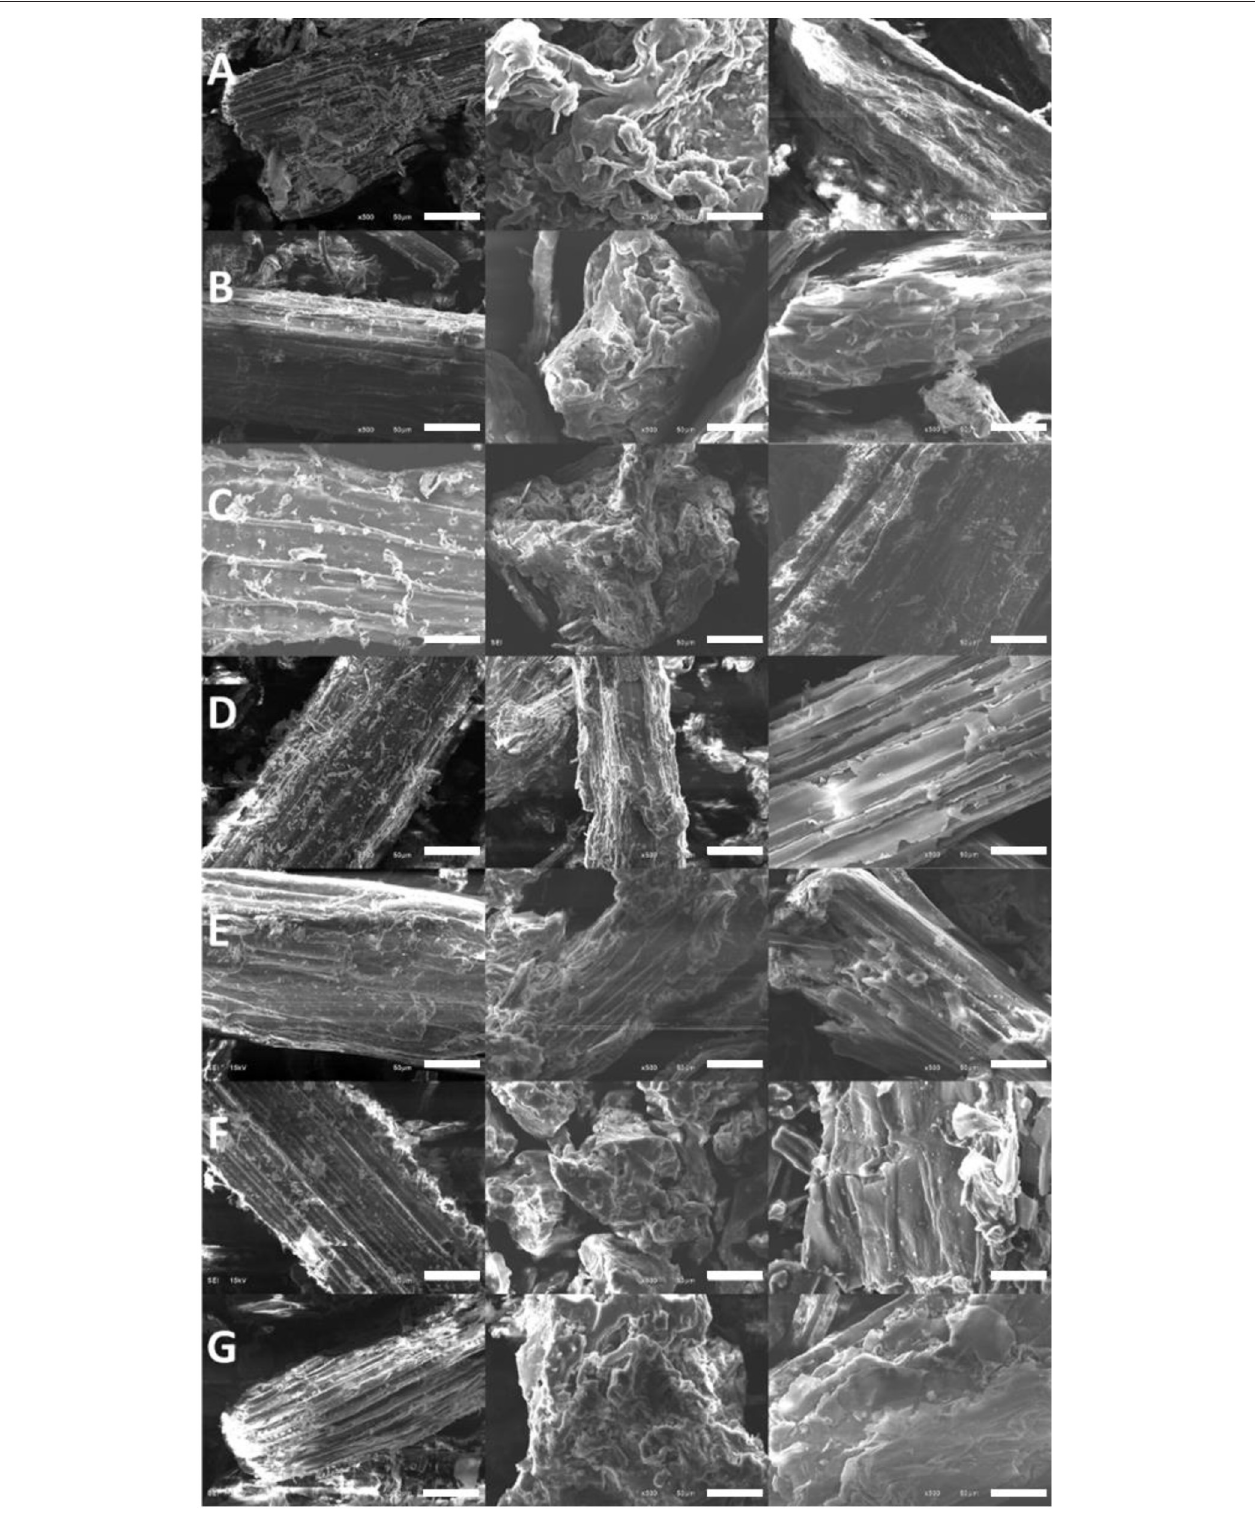
FIGURE 4 | SEM images of biomass that is untreated (left), treated with Emim Ac (middle), or treated with Bmim PF 6 (right). Biomass types are corn stover (A) , miscanthus (B) , pine (C) , sorghum (D) , sugar cane bagasse (E) , switchgrass (F) , and wheat straw (G) . The scale bar in each image is 50 µ m.